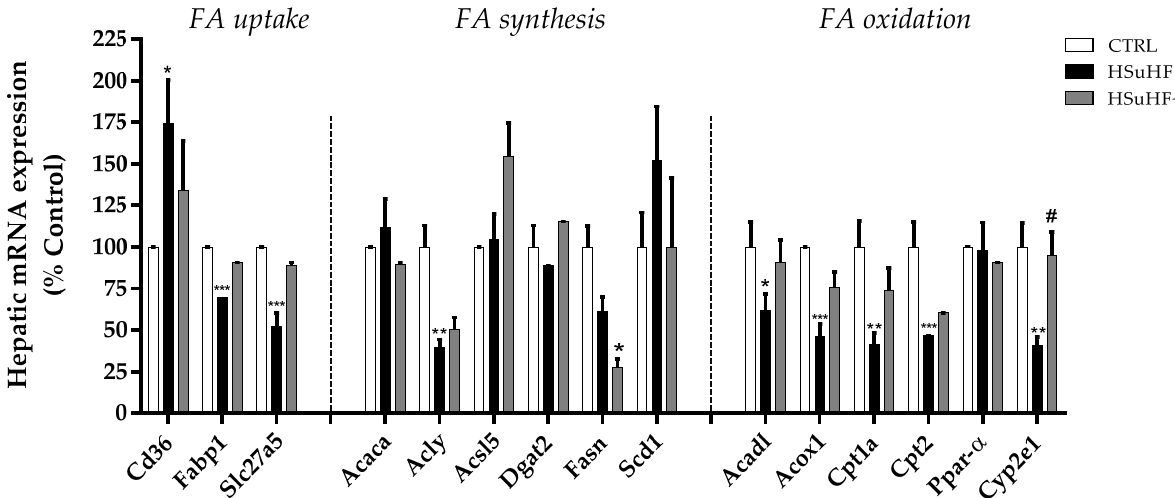
Figure 8. Hepatic mRNA expression of genes related with lipid metabolism of the CTRL, HSuHF, and HSuHF + BJ groups. Data are presented as the mean ± SEM. ( n = 6–8/group). * p < 0.05, ** p < 0.01, and *** p < 0.001 vs. CTRL group; # p <0.05 vs. HSuHF group. CTRL: control. HSuHF: high sucrose/high-fat. BJ: blueberry juice.